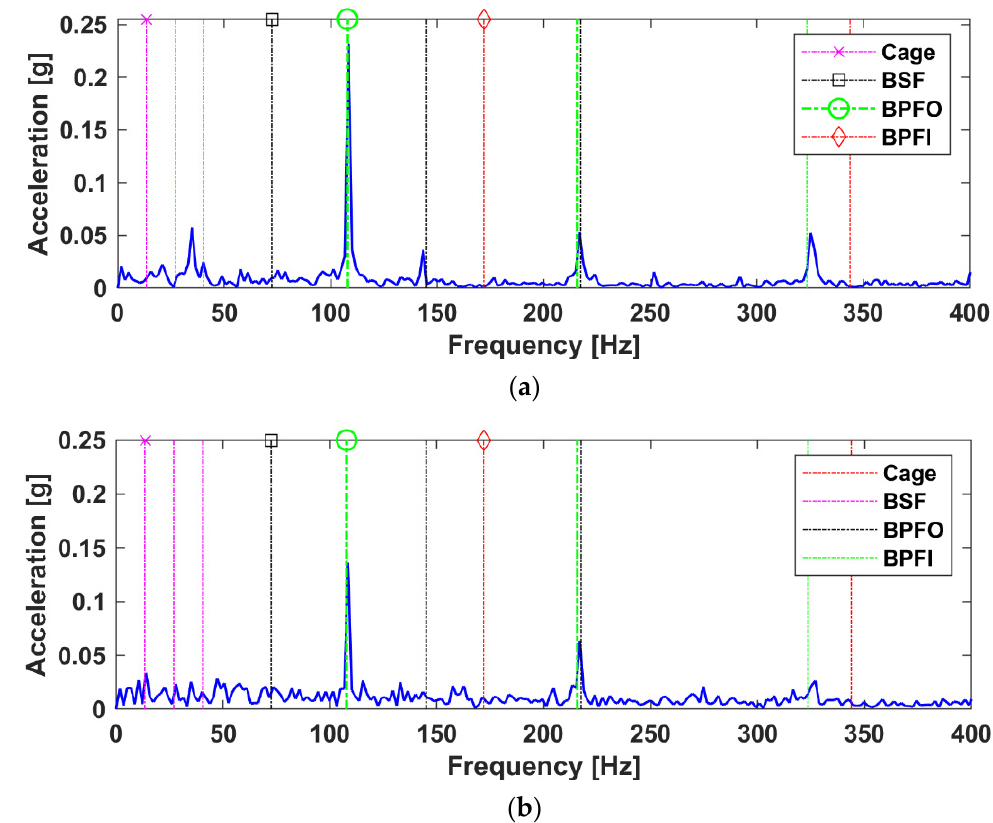
Figure 14. Case C results via LRANTD. ( a ) The amplitude spectrum of TS1 and ( b ) that of TS3.